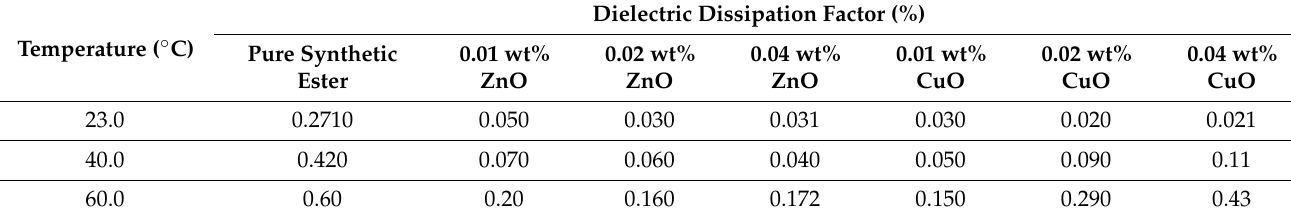
Table 6. The values of Dielectric dissipation factor (DDF) of different samples of oil. Dielectric Dissipation Factor Temperature ( ◦ C)